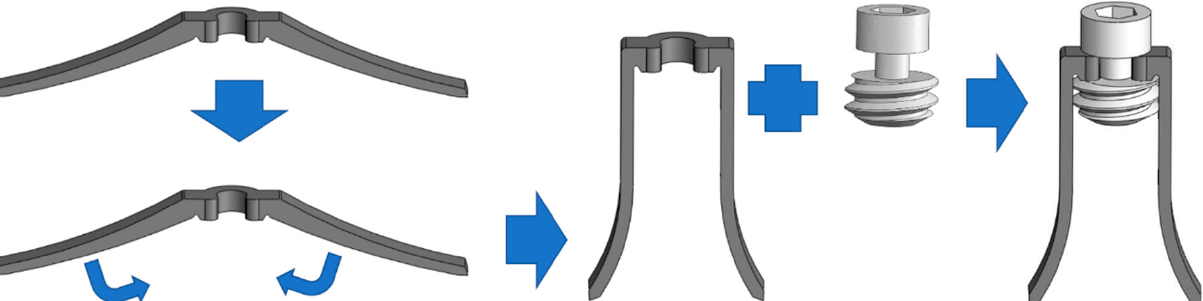
Figure 3. Barrette and insertion